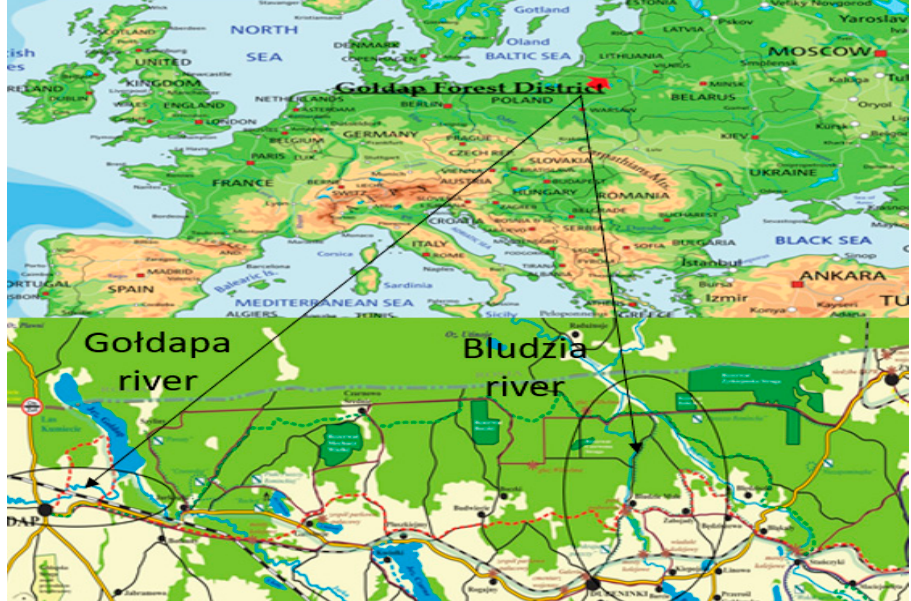
Figure 1. The location of Gołdapa and Bludzia rivers in the Gołdap Forest District in the Regional Directorate of State Forests, Bia ł ystok, Poland [17].